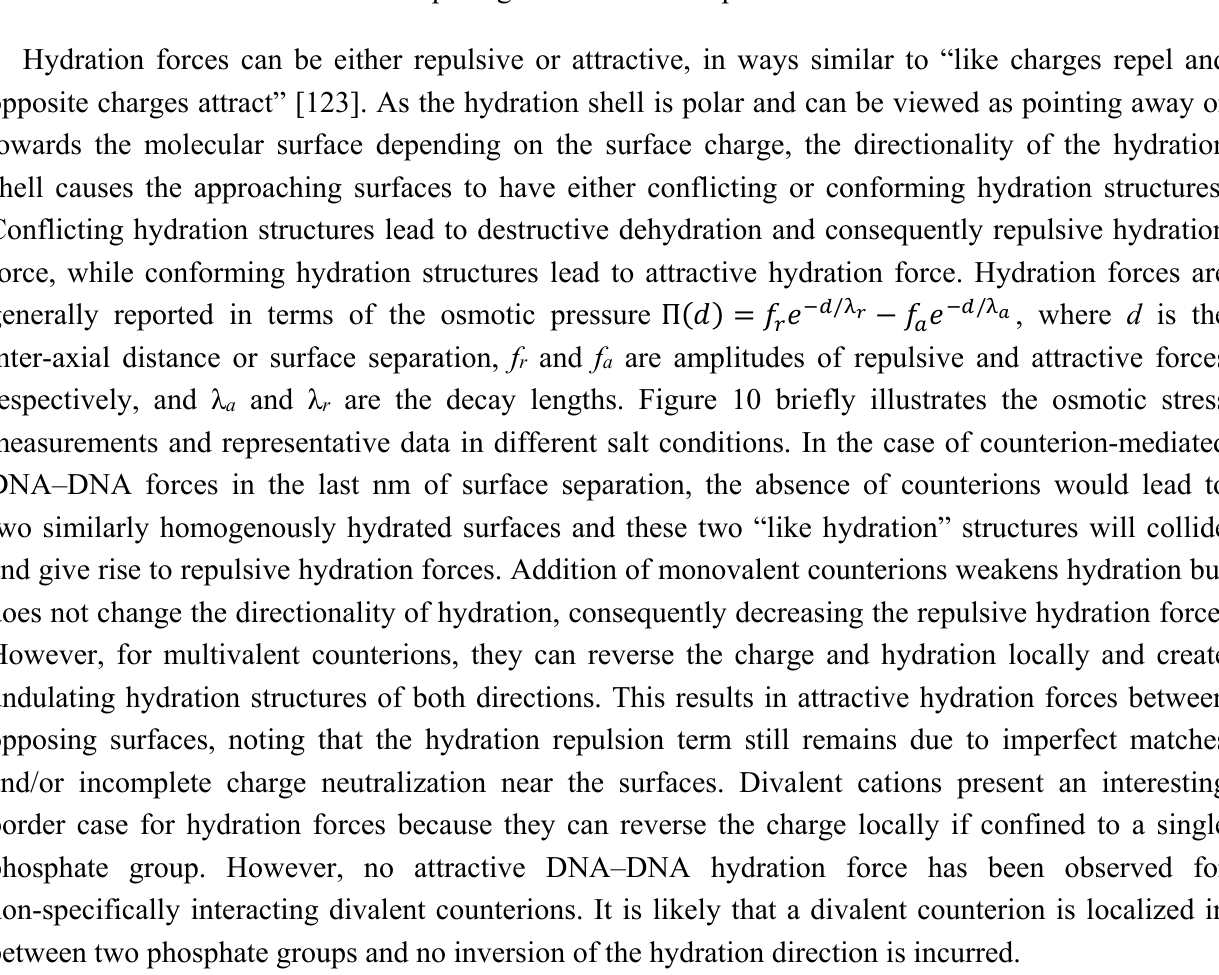
Figure 10. ( a ) Illustration of DNA arrays under osmotic stress; ( b ) Demonstration of shifts of the DNA–DNA X-ray diffraction peak as the osmotic pressure increases under DNA-condensing conditions. The peaks are scaled to assist visualization; ( c ) The force-spacing curves of dsDNA in varied salts as annotated in the legend. The x -axis shows the inter-axial spacing, whereas the surface-to-surface spacing is <2 nm. Symbols are experimental data and lines are the fits using exponential forces, as described in the text. The arrow indicates the DNA spacings at zero osmotic